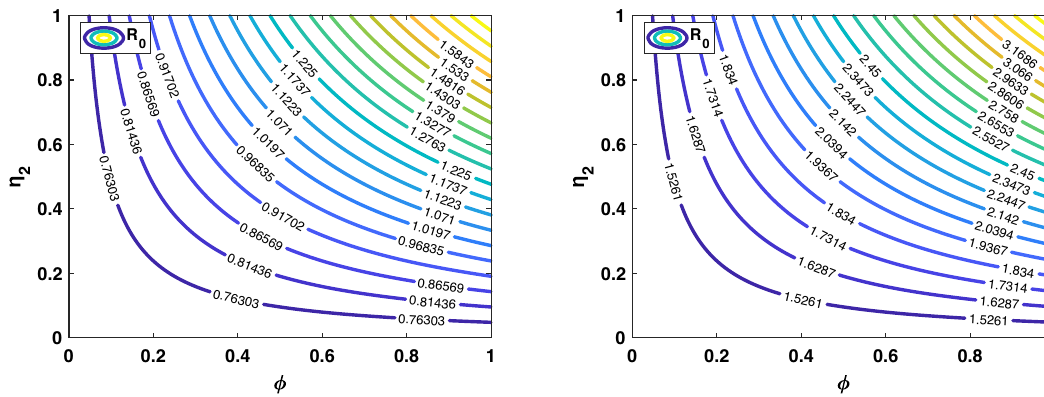
Figure 4: ( Left ) The contour plots of the reproduction number < (cid:3) 1 0 with the symptomatic to hospitalization rate ϕ and the hospitalization reduction factor in transmission rate η